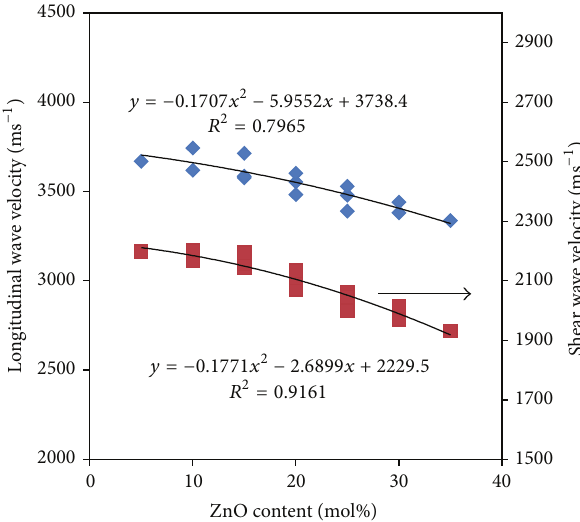
Figure 2: Variation of longitudinal, V 𝑙 (top), and shear, V 𝑠 (bottom), ultrasonic wave velocities for ZOFT glass